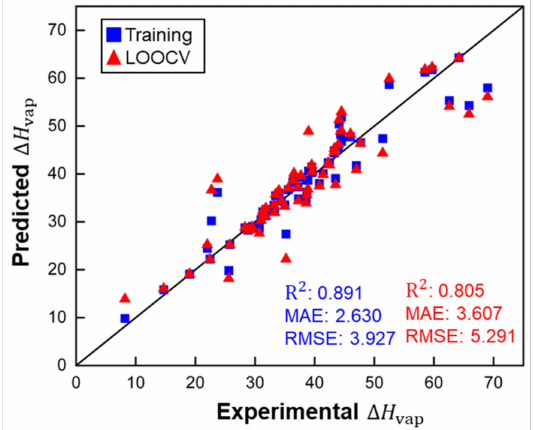
Figure 4. Performance of the MLR model for ∆ H vap predictions of small molecules (ARE for the training set: 0.072 and for LOOCV: 0.105). ∆ H vap , MAE and RMSE in kJ/mol. The performance comparison of the final KRR ( d = 1) and KRR ( d = 2) models is shown in Figure 5.